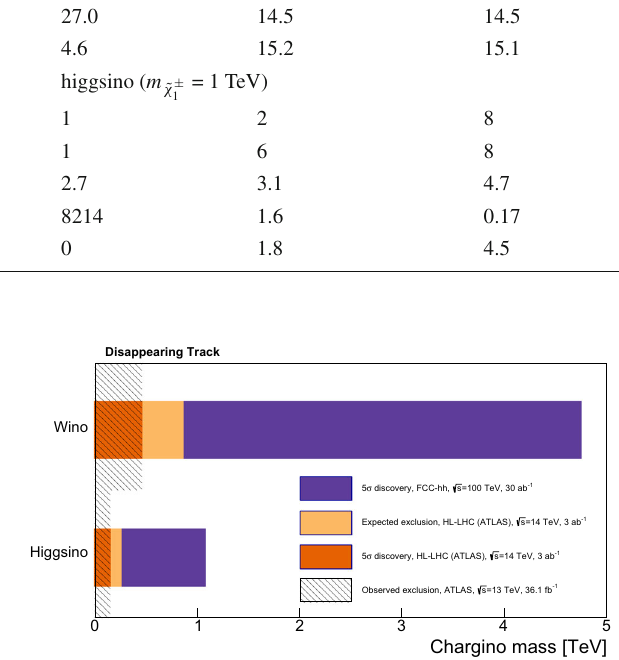
yields as well as the discovery significance for the 3 TeV wino and 1 TeV higgsino with 30 ab − 1 with the requirements of = 5 under the pileup N hit layer condition of (cid:8) μ (cid:9) = 500. The fake-track background rate is assumed to be same for both alternative layouts. The kinematic selection